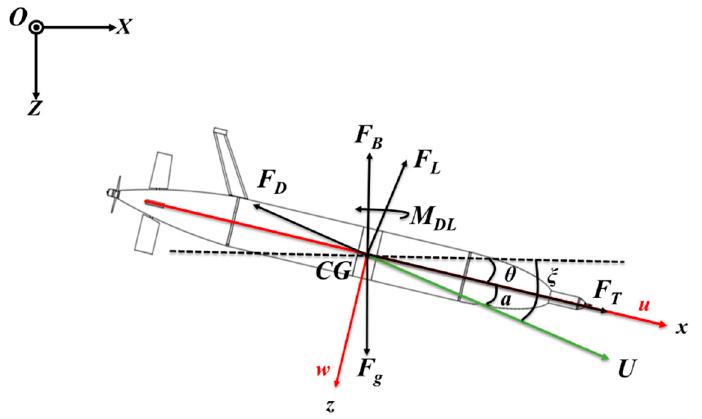
Figure 8. The force analysis of turbulence AUV in the vertical plane (descent) and definition of coordinate systems. The forces working on the turbulence AUV are buoyancy F B , gravity F g , lift F L , drag F D , thrust F T , and moment MDL . θ is the pitch angle, α is the angle of attack, 𝜉 is the path angle. u and w are the horizontal and vertical turbulence AUV speed components in a georeferenced coordinate system, respectively. The earth-based coordinates are X, Y (both horizontal), and Z (downward), while the AUV-based coordinates are x (along axis), y (to port), and z.